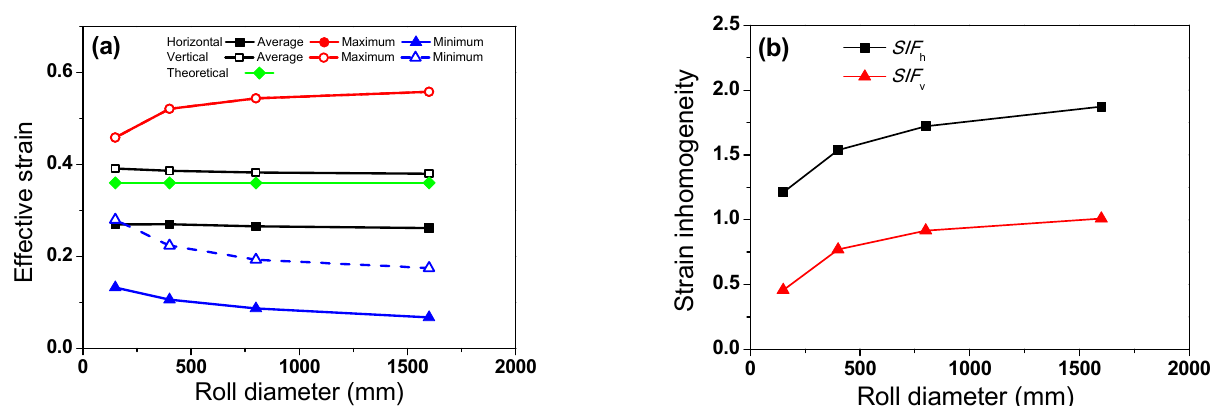
Figure 6. Comparison of the ( a ) ε max , ε min , and ε ave along the horizontal and vertical directions of the flattened wire and ( b ) SIF h and SIF v of the wire against roll diameter. Theoretical strain was obtained using Equation (3).